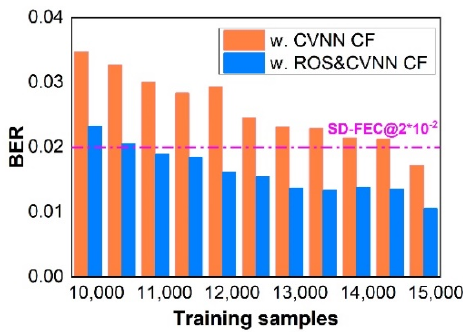
Figure 7. ( a ) The BER performance of PS-16QAM signals vs. the baud rate by using traditional DSP algorithms and nonlinear NN algorithms when the optical power into UTC-PD is fixed as 9 dBm. The constellation diagrams after CVNN NLE of ( b ) 3Gbaud and ( c ) 4Gbaud. Pink line: BER thresh- old for FEC coded symbols using soft decisions.